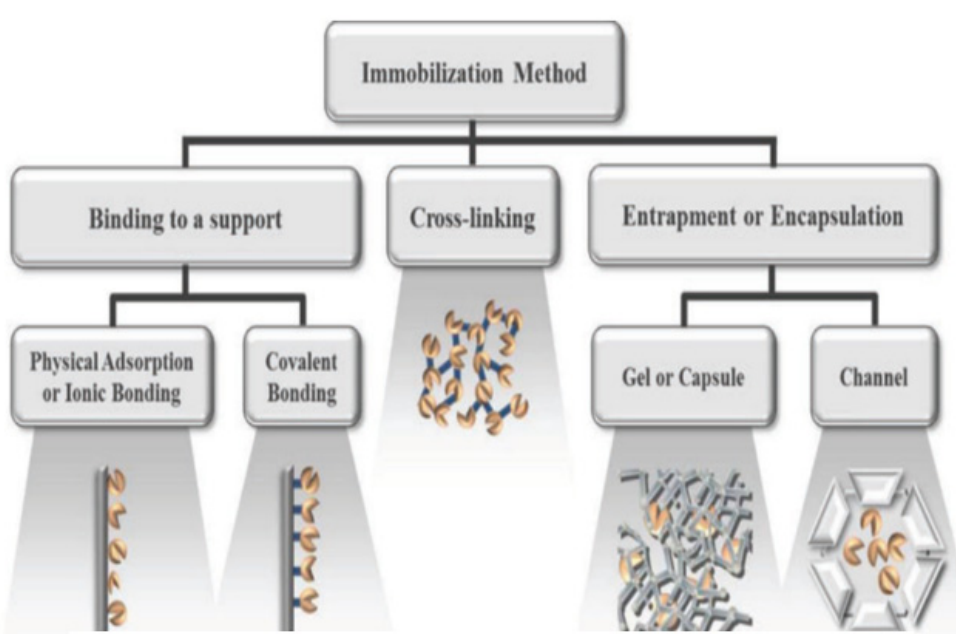
Figure 1. Overview of the different enzyme immobilization strategies [41].